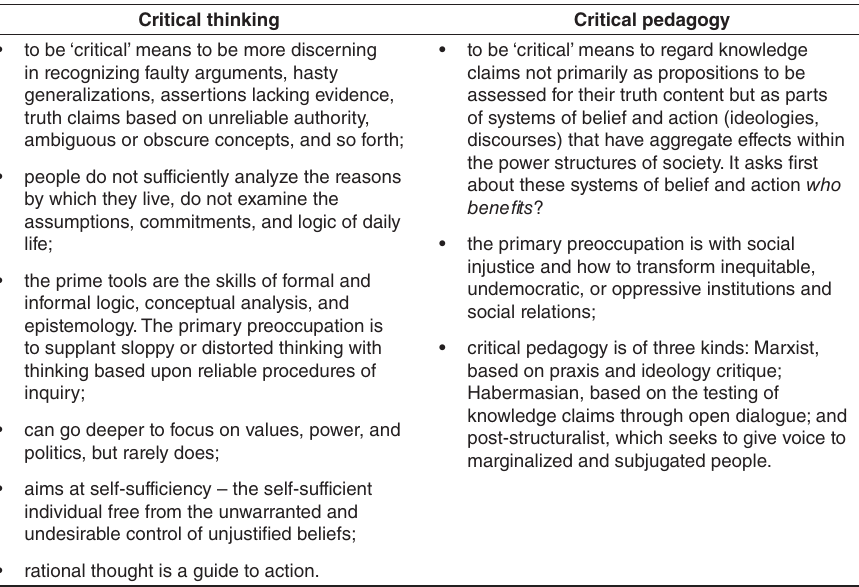
Table 1: Critical thinking and critical pedagogy compared (also see Johnson and Morris, 2010; Hovey, 2004; Burbules and Berk, 1999; Grundy,